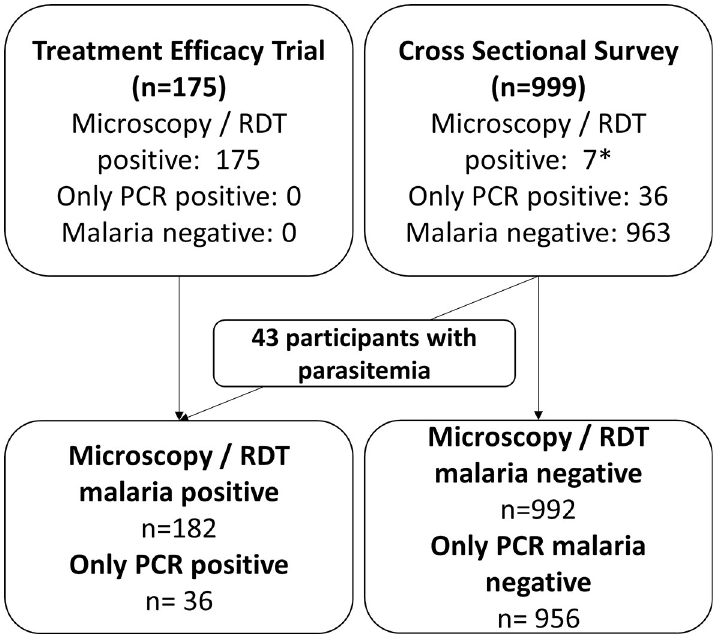
Fig 2. Study profile of participants enrolled in the treatment efficacy trial and cross-sectional survey. � Four participants had a P . falciparum parasitemia detected by RDT, but not by microscopy. PCR, polymerase chain reaction; RDT, rapid diagnostic